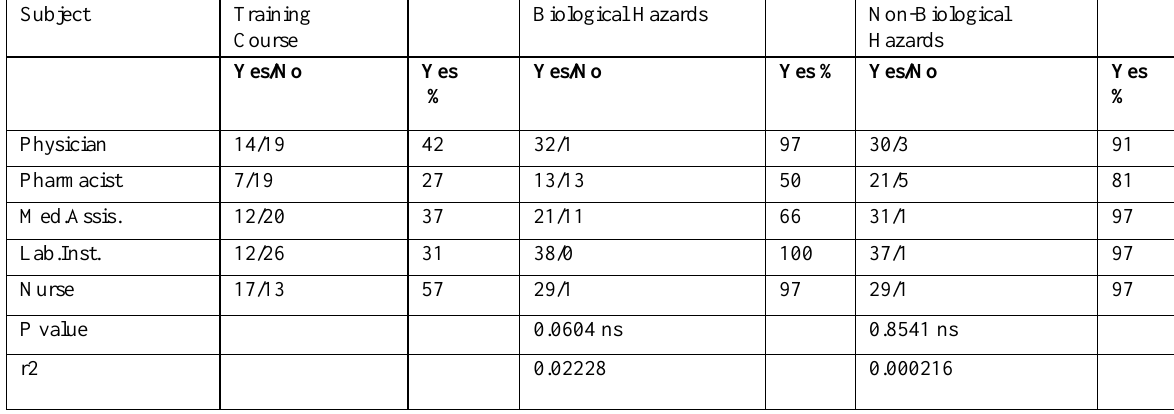
Table 6. Correlation between Training Course and Exposure to Biological/Non Biological